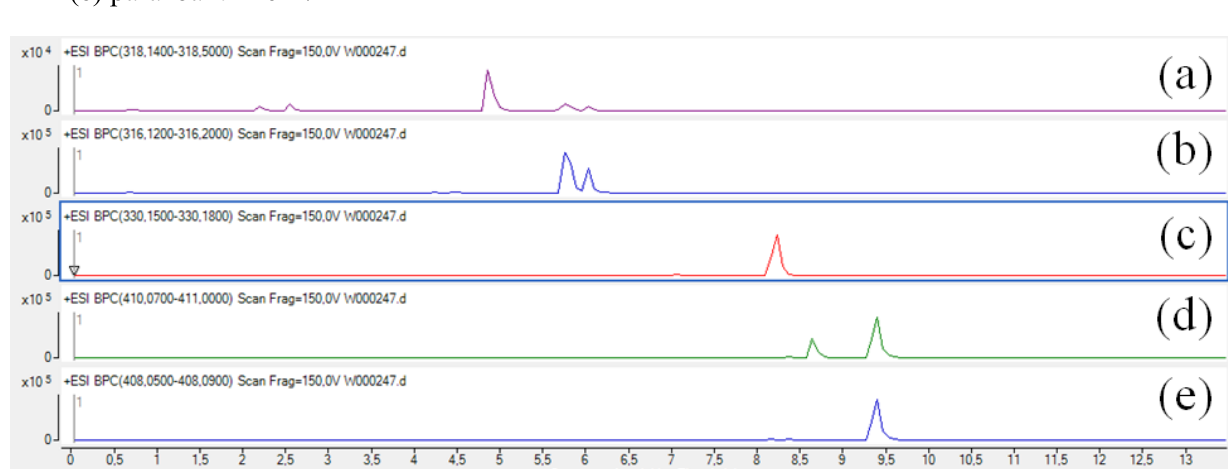
Figure 2. Extracted ions chromatograms (EIC) of the five known parazoanthines: ( a ) parazoanthine A, ( b ) parazoanthine B, ( c ) parazoanthine C, ( d ) parazoanthine D, ( e ) parazoanthine E.